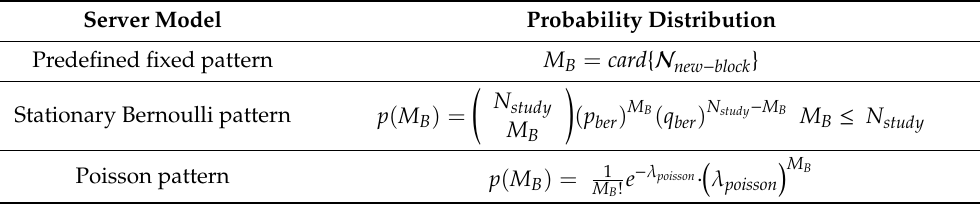
Table 1. Total number of generated blocks in the proposed scenario. Random